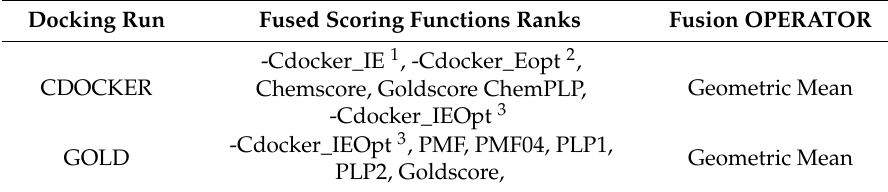
Table 10. Fusing ranking